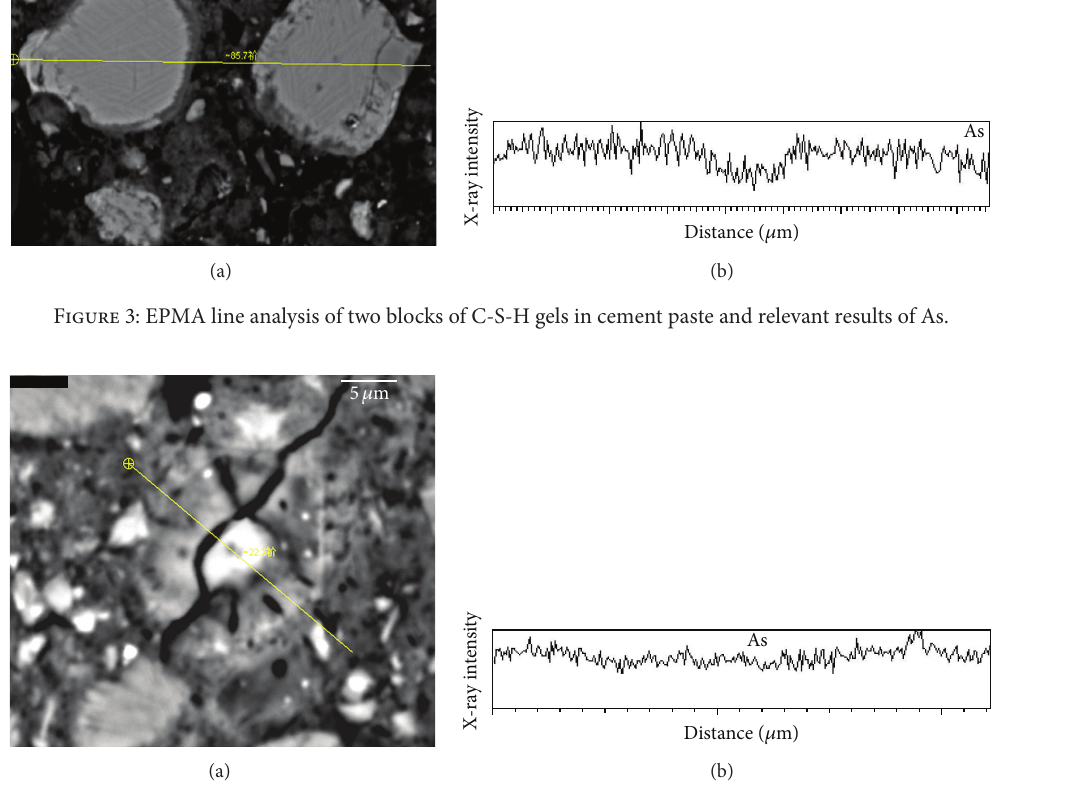
Figure 4: EPMA line analysis of CH crystal in cement paste and corresponding results of